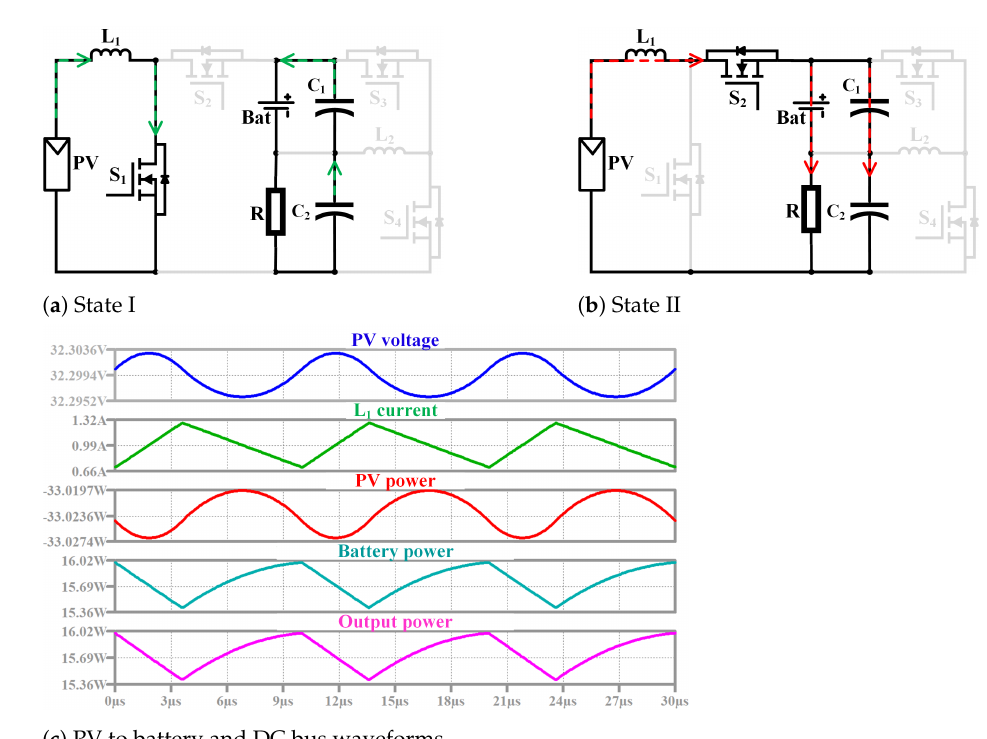
Figure 11. Type I-III-IC circuit Mode 5